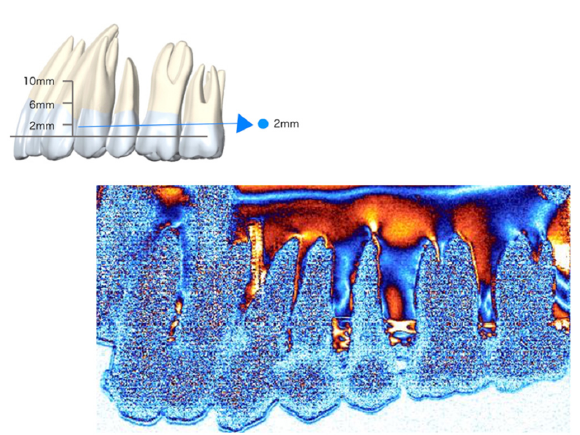
Figure 5. Two-millimeter retraction hook and 2 mm positioned posterior anchor model.